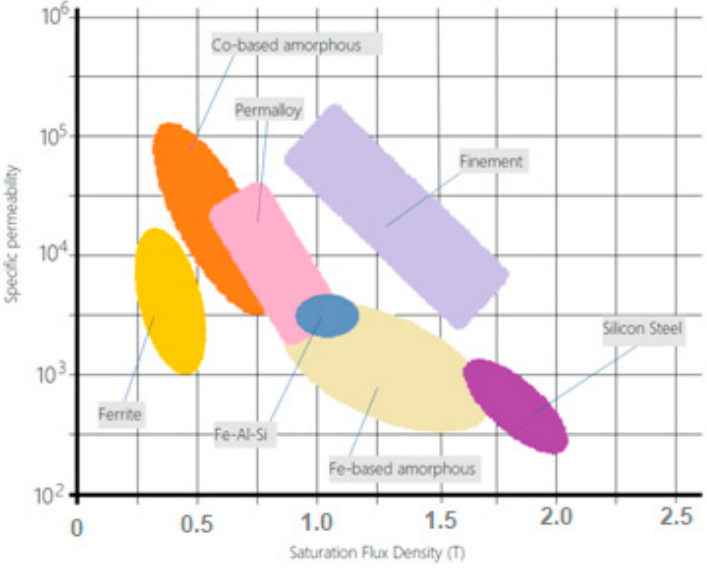
Figure 1. Relationship between magnetic permeability and magnetic induction in various types of soft magnetic materials. Own compilation based on [16].